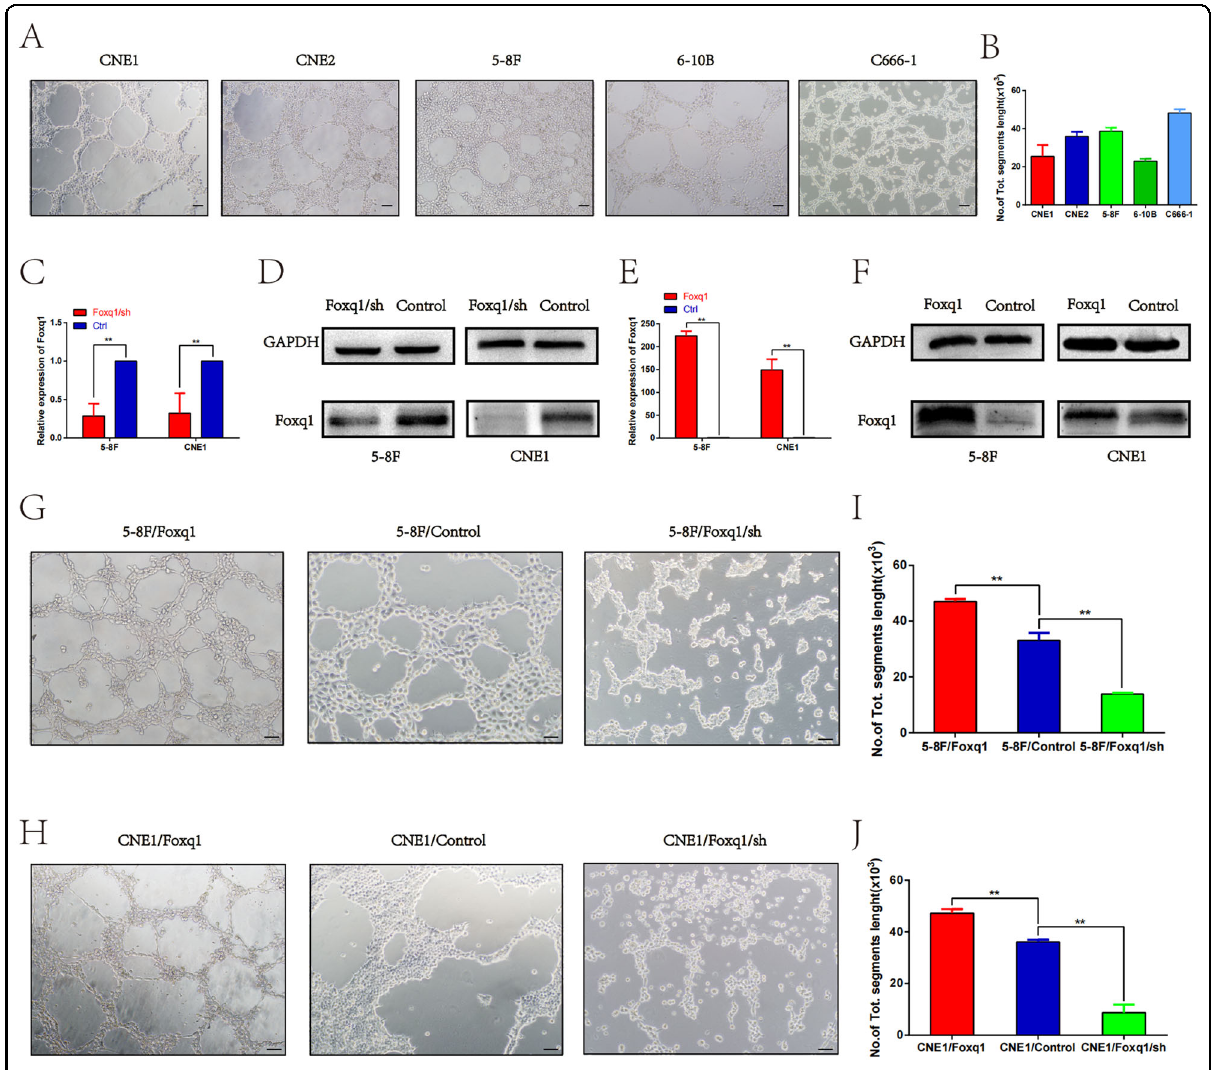
Fig. 2 Foxq1 promotes VM formation in NPC cells. A VM channel formation in 3D culture of different types of NPC cells (magni fi cation, ×200); Scale bars represent 50 μ m. B The statistical results of the average numbers of tubular structures in NPC cells that was counted using ImageJ. C , D qRT-PCR (left) and western blot (right) of Foxq1 expression in Foxq1 knockdown 5 – 8F, and CNE1. E , F qRT-PCR (left) and western blot (right) of Foxq1 expression in Foxq1 overexpressing 5 – 8F and CNE1. G , H VM channel formation in Foxq1 dysregulated 5 – 8F, and CNE1 (magni fi cation, ×200); Scale bars represent 50 μ m. I , J The statistical results of the average number of tubular structures in Foxq1 dysregulated 5 – 8F, and CNE1 that was counted using ImageJ. Data are presented as mean ± SD of three independent